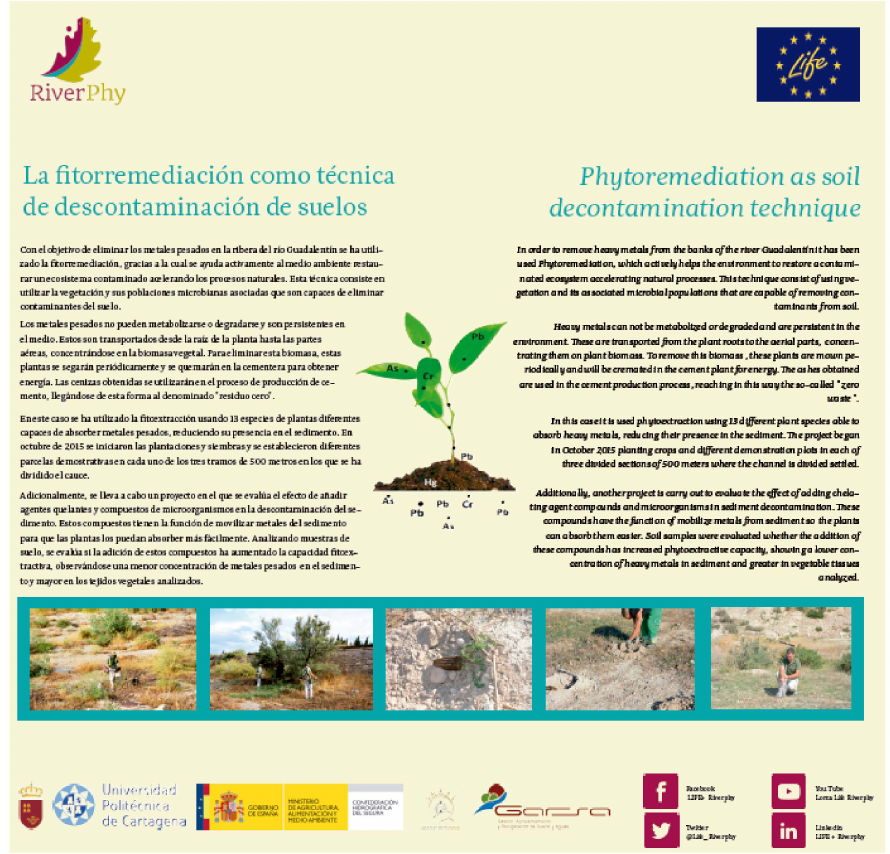
Figure A13. Example of a panel in Case Study